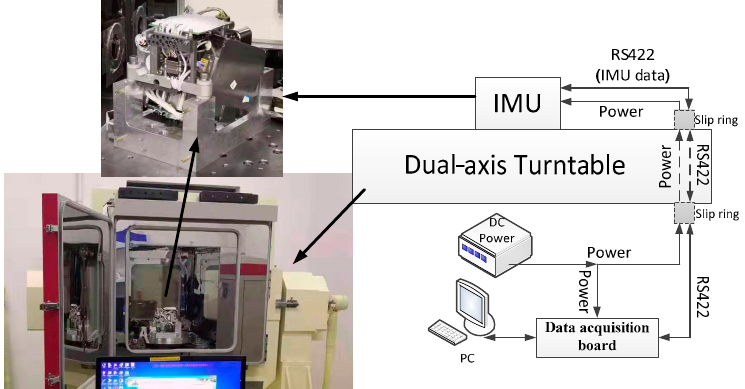
Figure 3. Experimental setup.